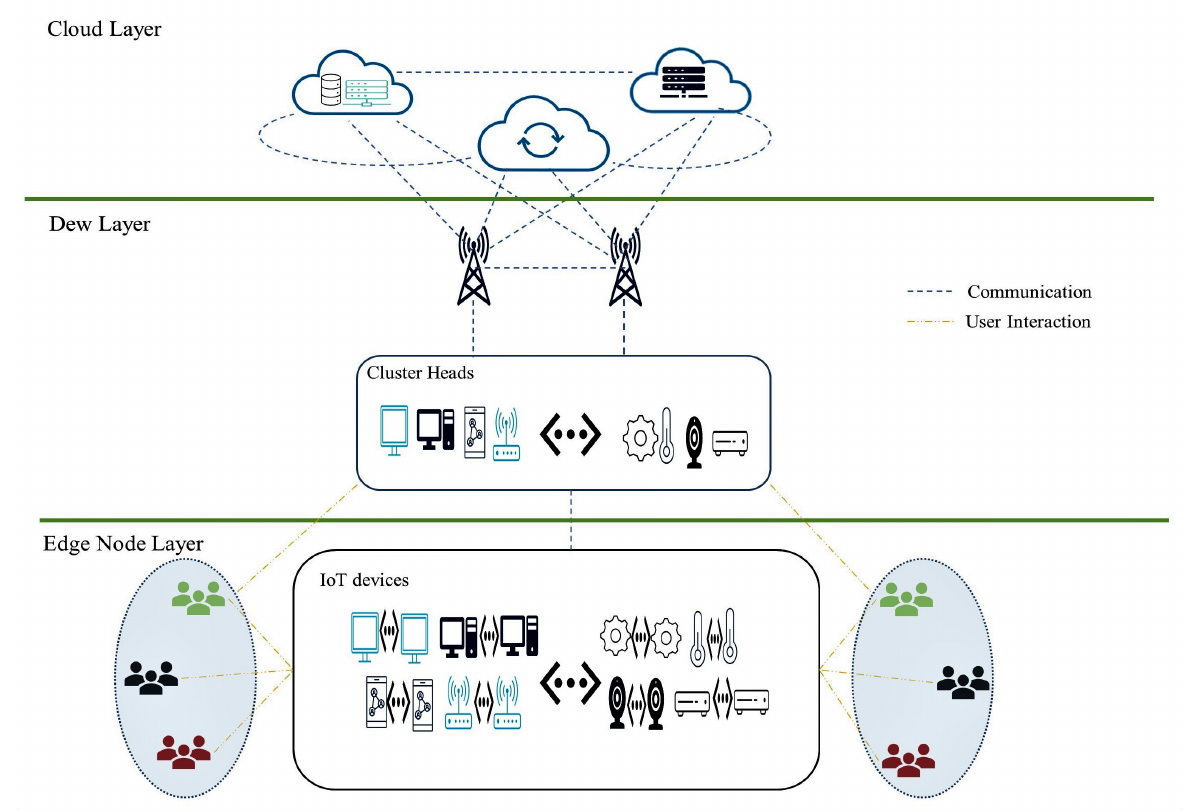
Figure 1. Proposed